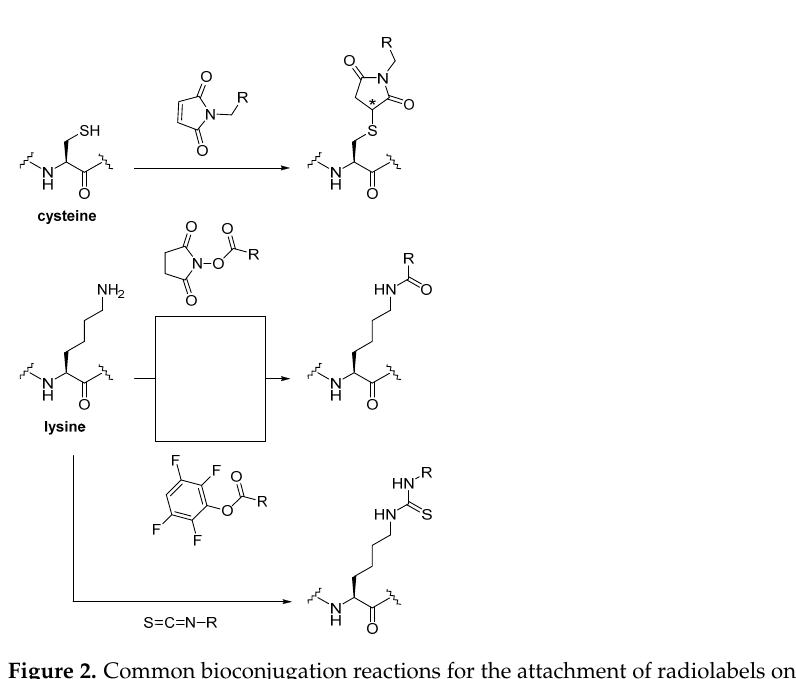
Figure 2. Common bioconjugation reactions for the attachment of radiolabels on cysteine and lysine residues within the nanobody [12]. Asterisk (*) indicates a chiral center with an undefined ratio of the two stereoisomers.